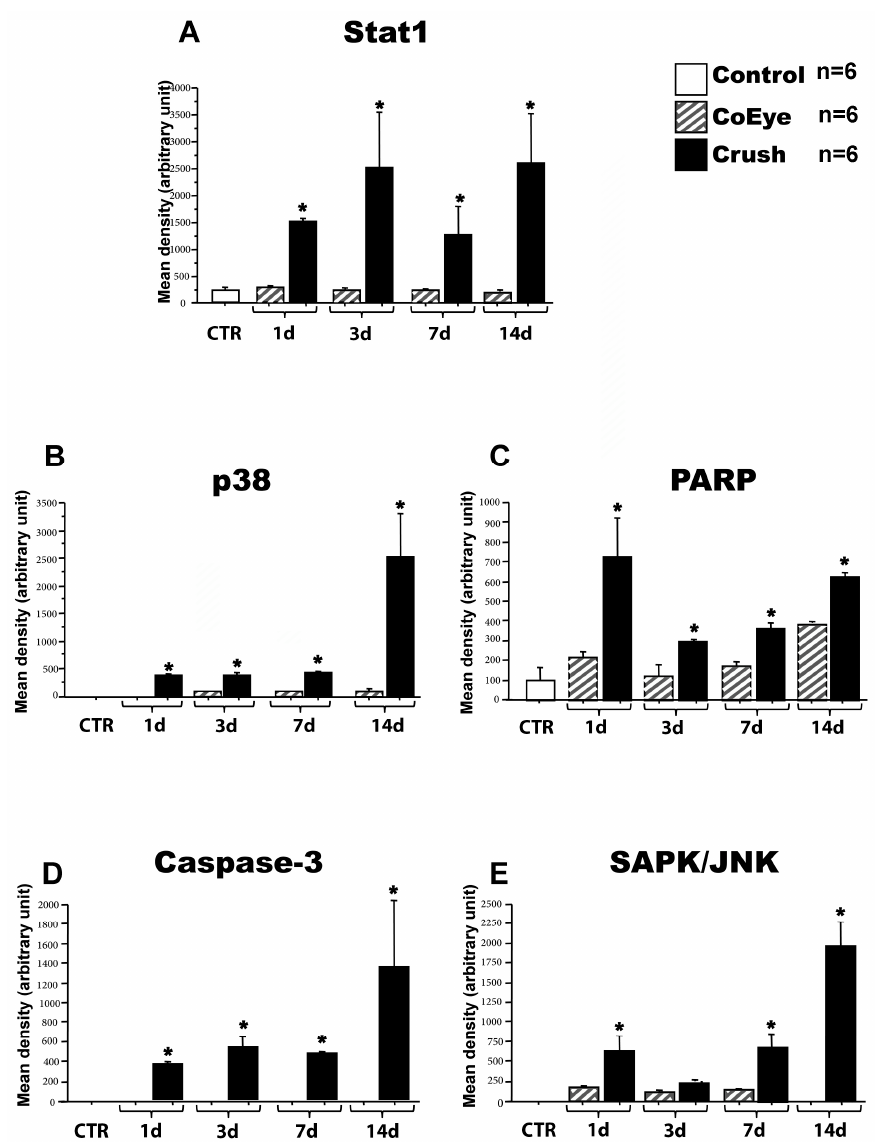
Figure 2. Intracellular pathways modulated in the retina 1 to 14 days after crush ( n = 6 per group): ( A ) STAT1; ( B ) p38; ( C ) PARP; ( D ) Caspase-3; and ( E ) SAPK/JNK. * p < 0.05 vs. CoEye. CoEye: contralateral eye; 1–14 d: 1 to 14 days after crush.